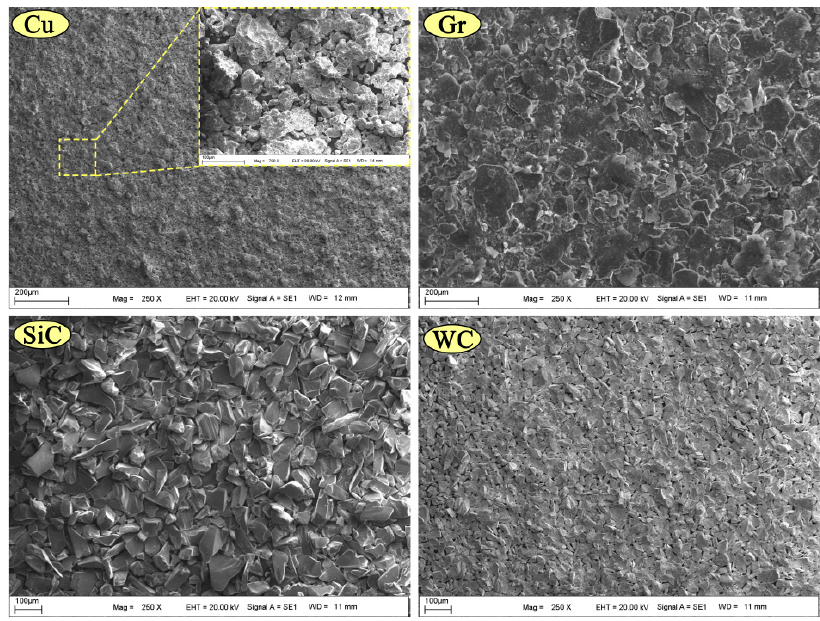
Table 2. The reinforcement ratios of composite samples.